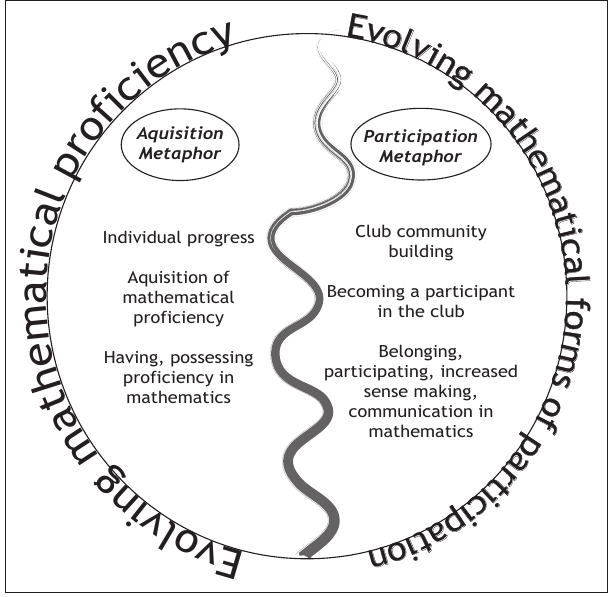
FIGURE 1: Club metaphorical